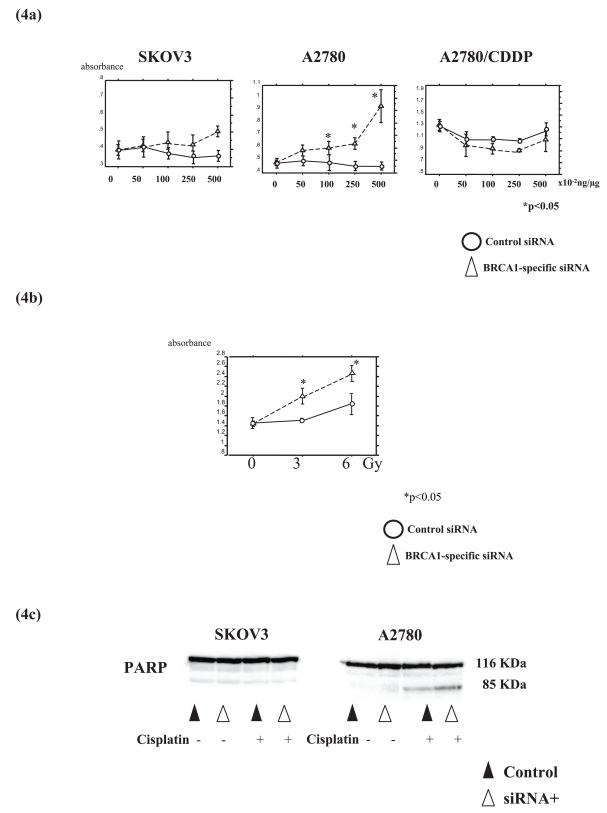
BRCA1 suppression increases the apoptosis of ovarian cancer cells under cisplatin treatment or under irradiationApostrand assay shows that cisplatin-induced apoptosis were significantly increased in BRCA1-siRNA-transfected A2780 cells (a). After exposure to 3 and 6 Gy irradiation, the increase in apoptosis was observed in BRCA1-siRNA-transfected A2780 cells, but not in other cells (b).PARP cleavage assay (c) demonstrating the presence of the cleaved PARP Mr 85,000 fragment indicative of apoptosis in A2780 cells transfected with the BRCA1-specific siRNA compared with A2780 cells. In contrast, the SKOV3 cells fail to undergo PARP cleavage under cisplatin treatment.